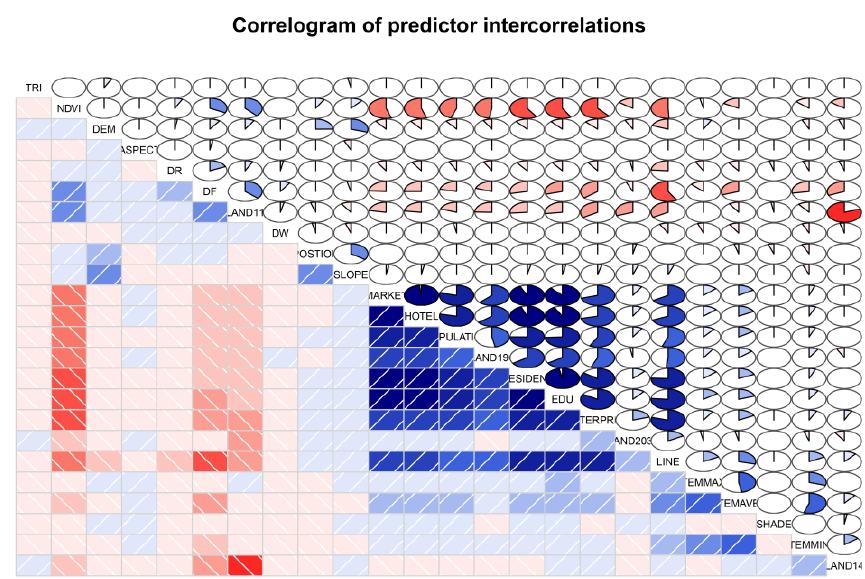
Figure 7. Correlogram of the explanatory variables. Red indicates a negative correlation and blue indicates a positive correlation. The larger the covered area in the fan diagram, the greater the absolute correlation value is.